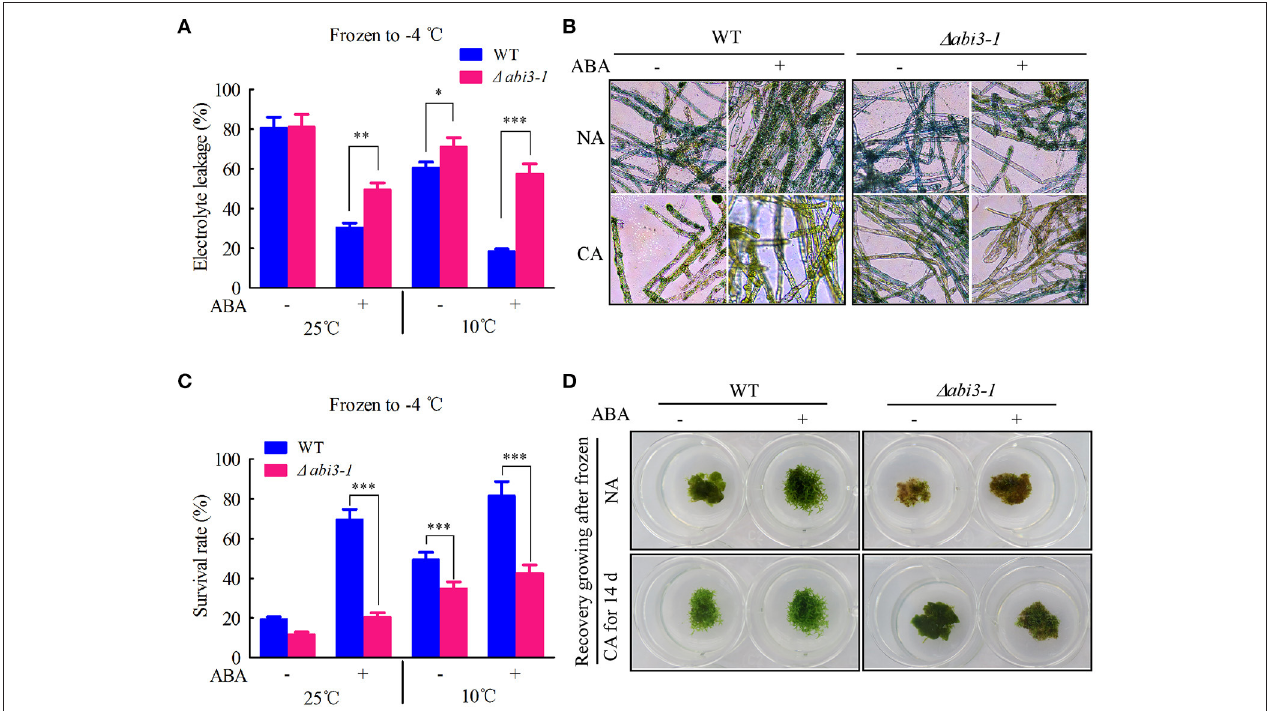
FIGURE 9 | PpABI3 is involved in ABA-dependent freezing tolerance regulation. (A) Electrolyte leakage rate analysis. Tissues of WT and ∆ abi3-1 with or without cold acclimation were treated or not with 1 µ M ABA, then frozen to − 4 ◦ C. After thawing, electrolyte leakage was measured to estimate cell injury. Error bars represent SD ( n = 3), and two-way ANOVA was used to determine the statistical significance (* P < 0.05; ** P < 0.01; *** P < 0.001). (B) Cell death rate estimation. Frozen-thawed cells were stained with 0.5% Evans Blue to analysis the cell death of WT and ∆ abi3-1. (C) Survival rate analysis. Tissues of WT and ∆ abi3-1 with or without cold acclimation were treated or not with 1 µ M ABA, then frozen to − 4 ◦ C, after thawing the cells survival rate were estimated according to Evans Blue staining in (B) . Error bars represent SD ( n = 3), and two-way ANOVA was used to determine the statistical significance (*** P < 0.001). (D) Recovery growing after frozen to − 4 ◦ C. Frozen-thawed protonematal tissues of WT and ∆ abi3-1 were transferred onto fresh BCD medium and regrown under standard condition for 7 days to estimate the recovery growth